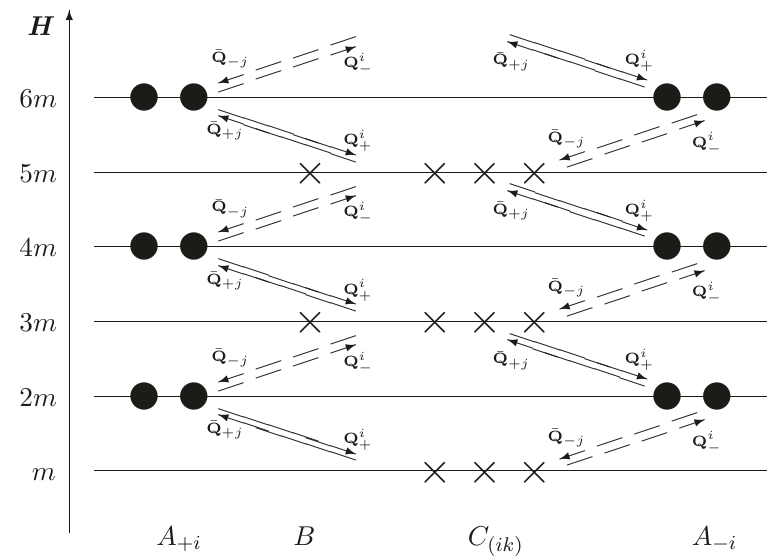
Figure 2 . The degeneracy of energy levels with respect to H = H − 2 m F for q = 1 / 2. Circles and crosses denote bosonic and fermionic states, respectively. Solid lines correspond to the action of Q i + and ¯ Q + j , while dashed lines correspond to the action of Q i − and ¯ Q − j